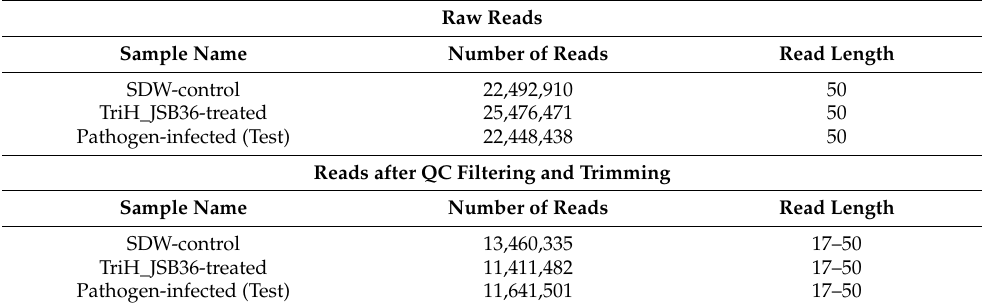
Figure 1. Length distribution analysis of reads for SDW-control, TriH_JSB36-treated, and pathogen- infected (Test) samples used for miRDeep2 analysis. Table 1. Number of raw reads and read length distribution before and after QC filtering and trimming of SDW-control, TriH_JSB36-treated, and pathogen-infected (Test) samples used for miRDeep2 analysis obtained by high-throughput